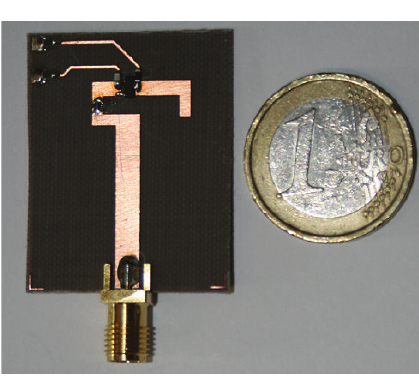
Figure 3: Prototype of the proposed antenna.